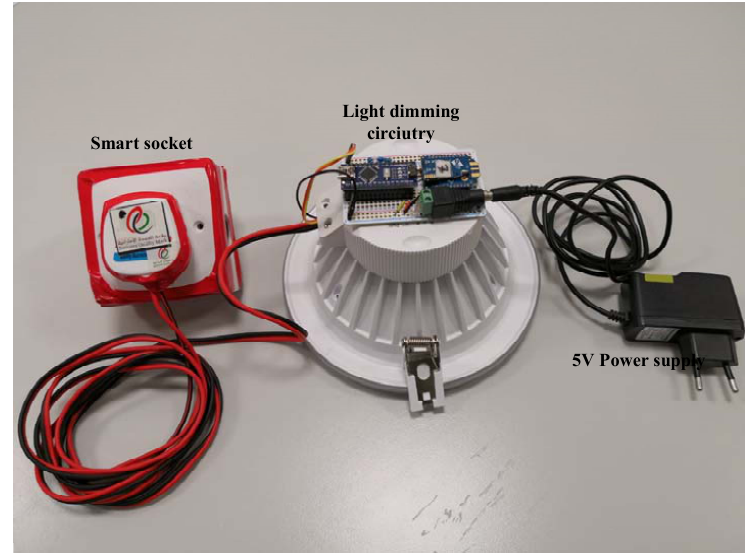
Figure 11. Experimental setup of the LED light.